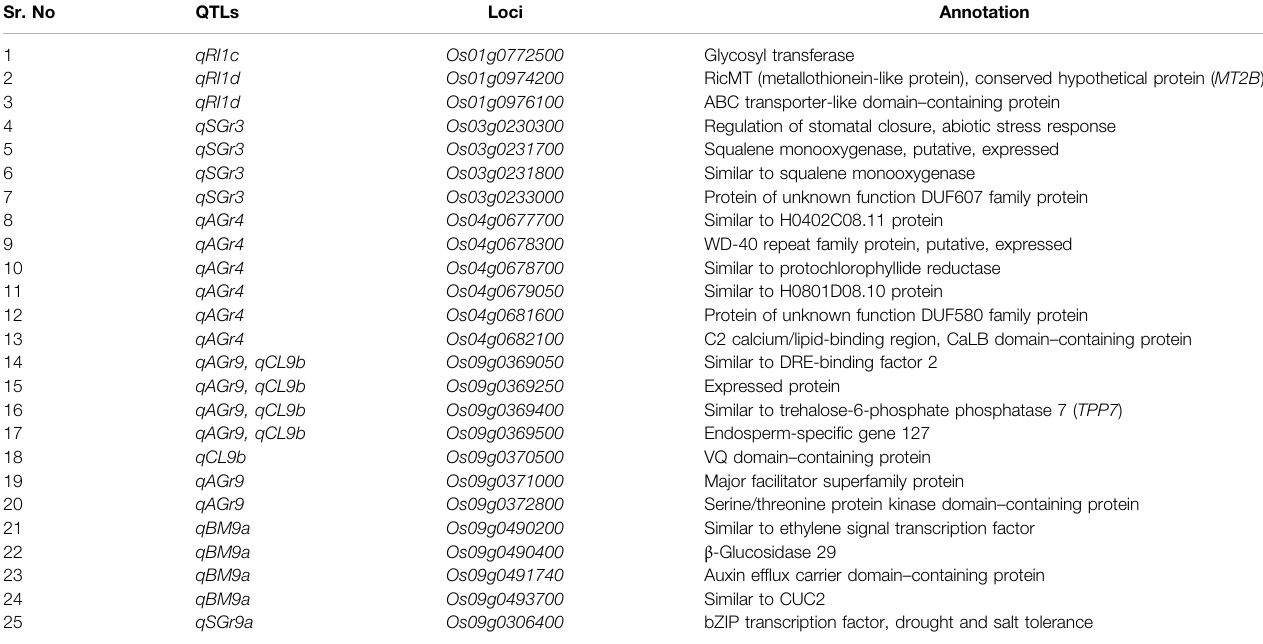
TABLE 2 | List of 25 candidate genes for seven important QTLs identi fi ed at under salinity and anaerobic stresses. Sr.